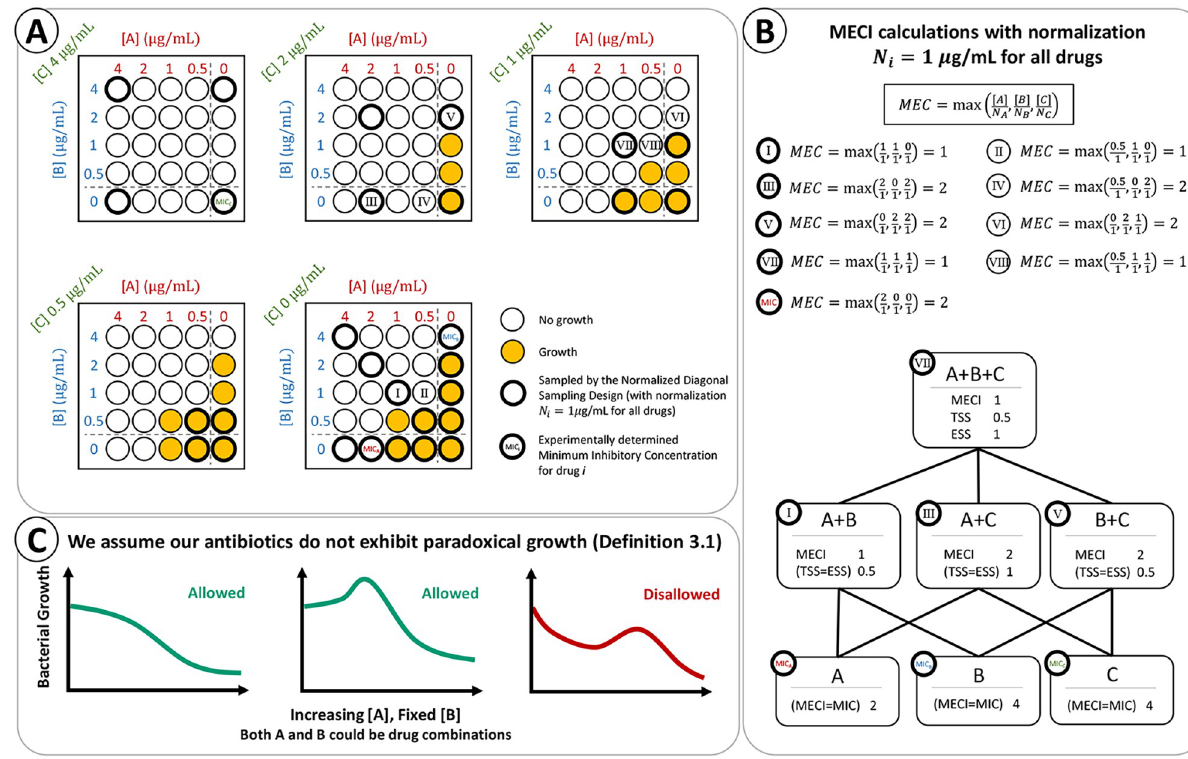
Fig 1. Calculation of the MECI, TSS, and ESS for a three-drug experiment. (A) Testing three drugs at four concentrations each could be performed exhaustively using a three-dimensional checkerboard assay, as depicted here. When the effectiveness measure is taken to be the absence of visible growth, the MEC can be calculated for each effective measurement in the checkerboard assay. (B) Computation of select MEC values from the checkerboard assay. The MECI of a drug combination is the minimum MEC among tested combinations. The MECI, TSS, and ESS of all subsets are computed according to their definitions, with normalization N = 1 μ g/mL for all drugs. The well in the upper-left corner of each combination’s i calculated values witnesses the MECI of that combination; we see that the wells tested by the NDS design (shown with bold edges) are sufficient to identify the MECI. (C) If the behavior of the antibiotics satisfies Definition 3.1, we prove that the NDS design always identifies the MECI for every combination tested. We illustrate some examples of allowed and disallowed behavior of the measured response as a function of increasing some antibiotic (combination) A as the concentration of antibiotic (combination) B remains